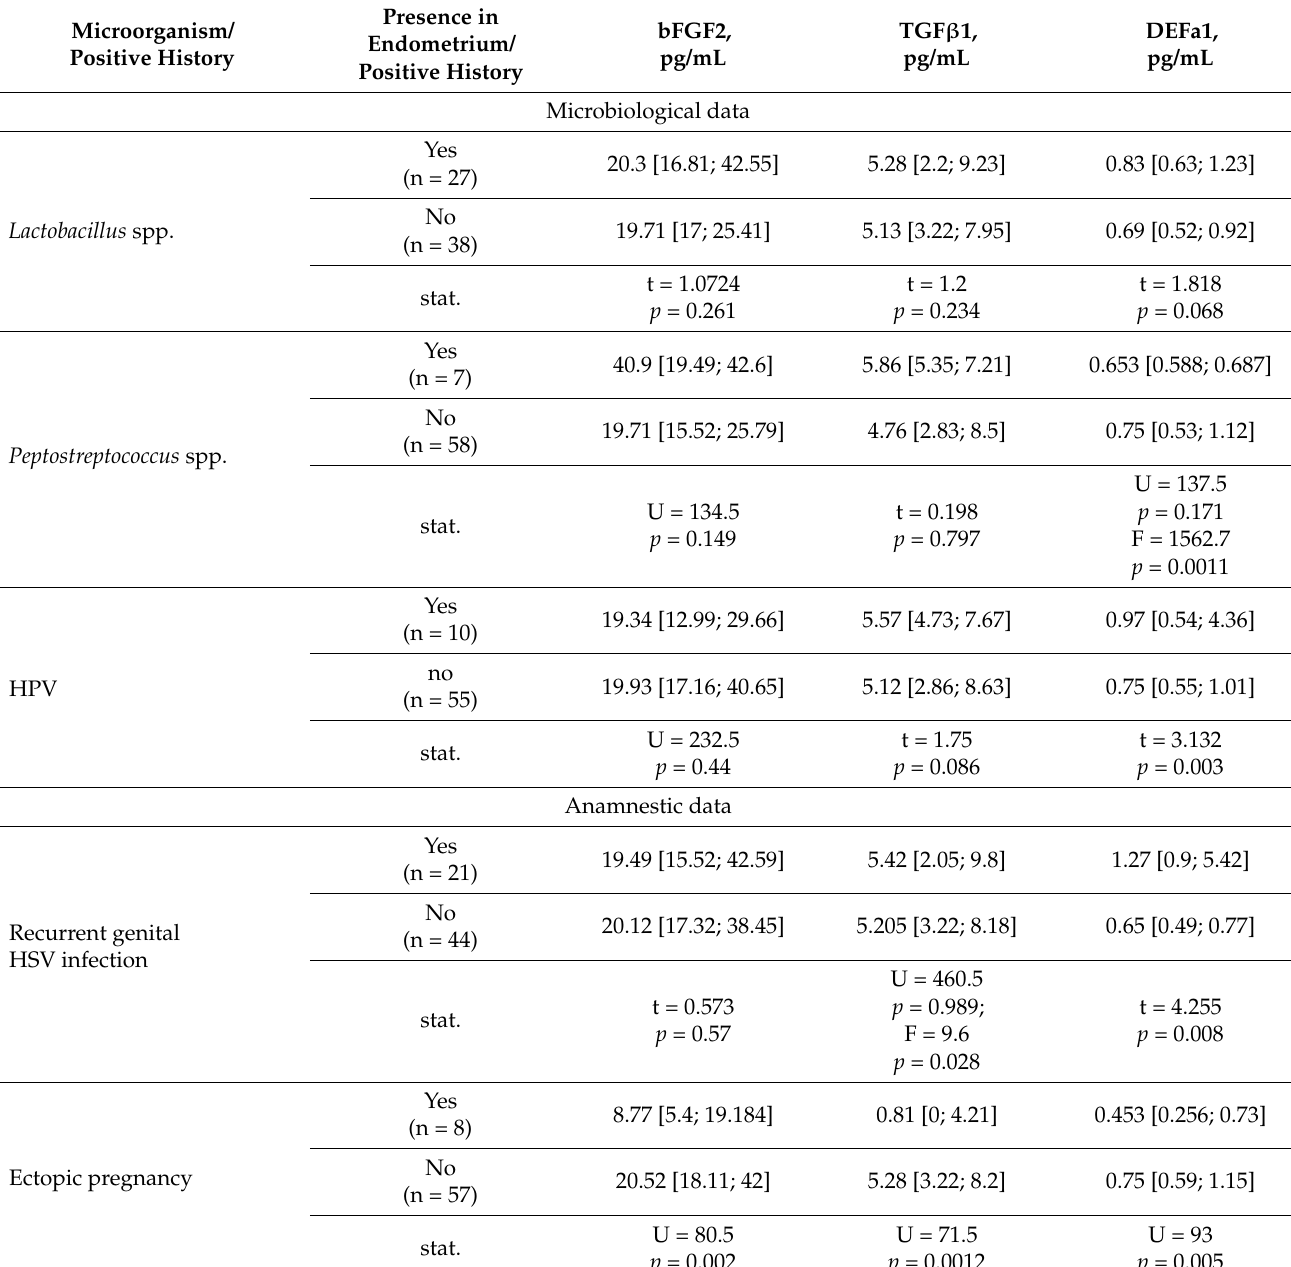
Table 3. Endometrial TGF β 1, bFGF2, and DEFa1 concentrations among patients with idiopathic infertility in relation to microorganisms